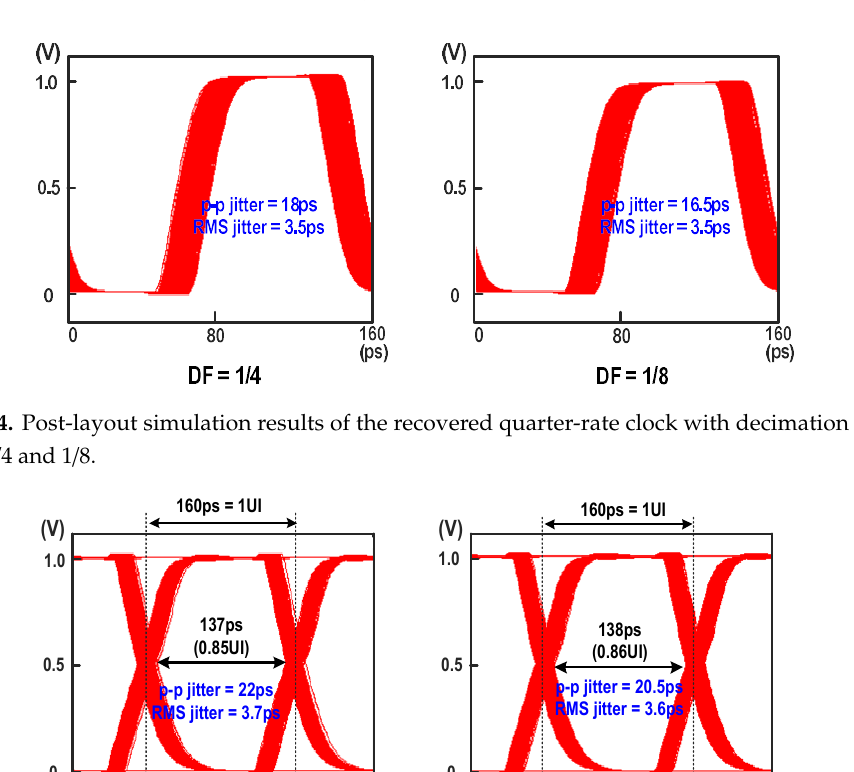
Figure 14. Post-layout simulation results of the recovered quarter-rate clock with decimation factor (DF) = 1/4 and 1/8.